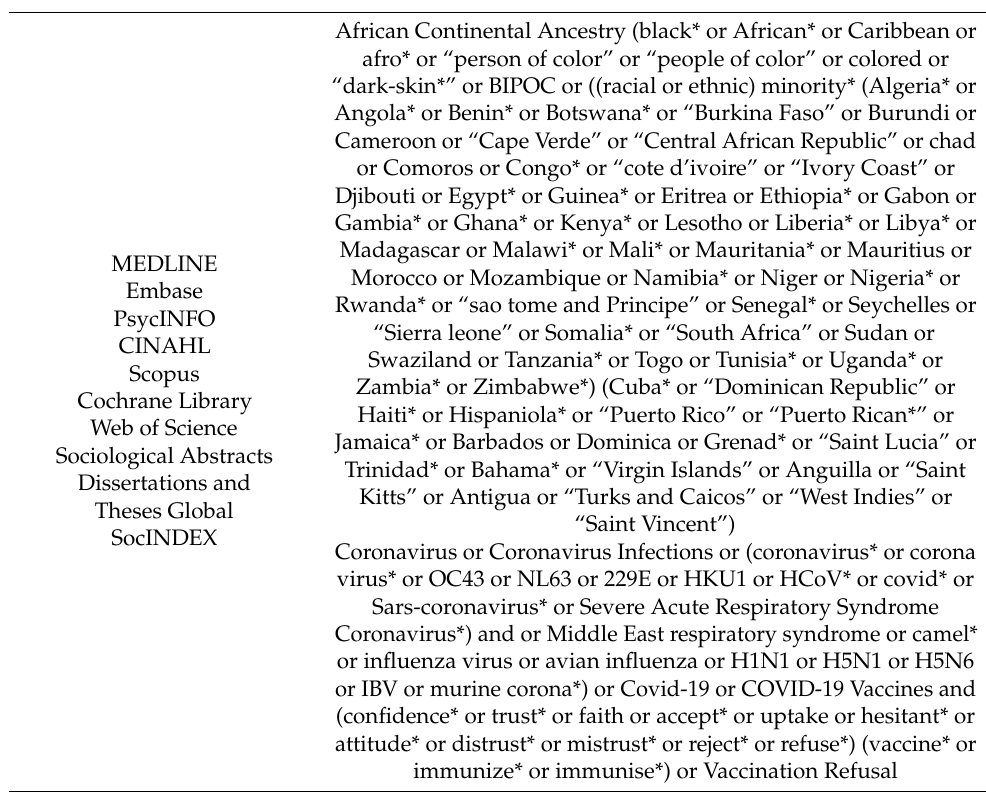
Table 1. Key Search